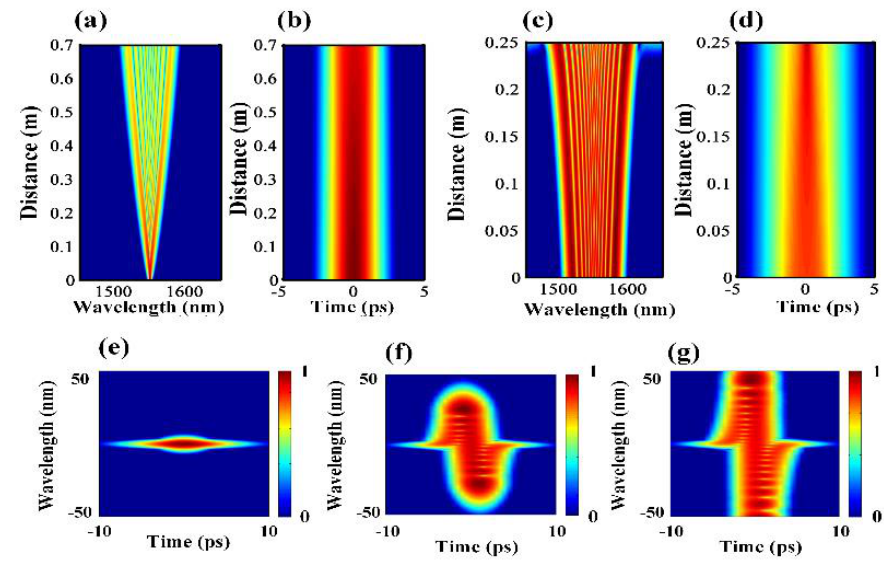
Figure 5. ( a , b ) Evolution of the pulses and the spectrum in 0.7 m ND TMF; ( c , d ) evolution of the pulses and the spectrum in 0.2 m TMF; ( e ) the initial pulse trace; ( f ) the pulse trace after the ND zone; ( g ) the pulse trace after the AD